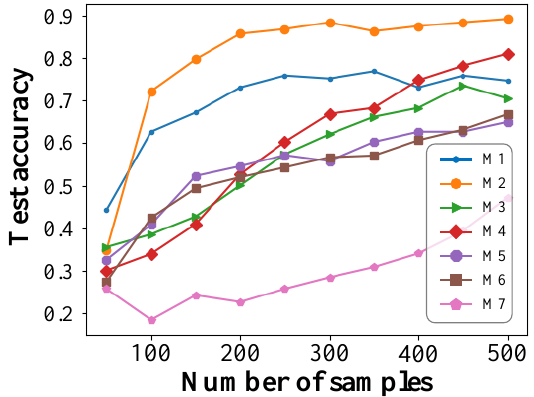
Figure 10. Test accuracy of each model at different sample sizes.